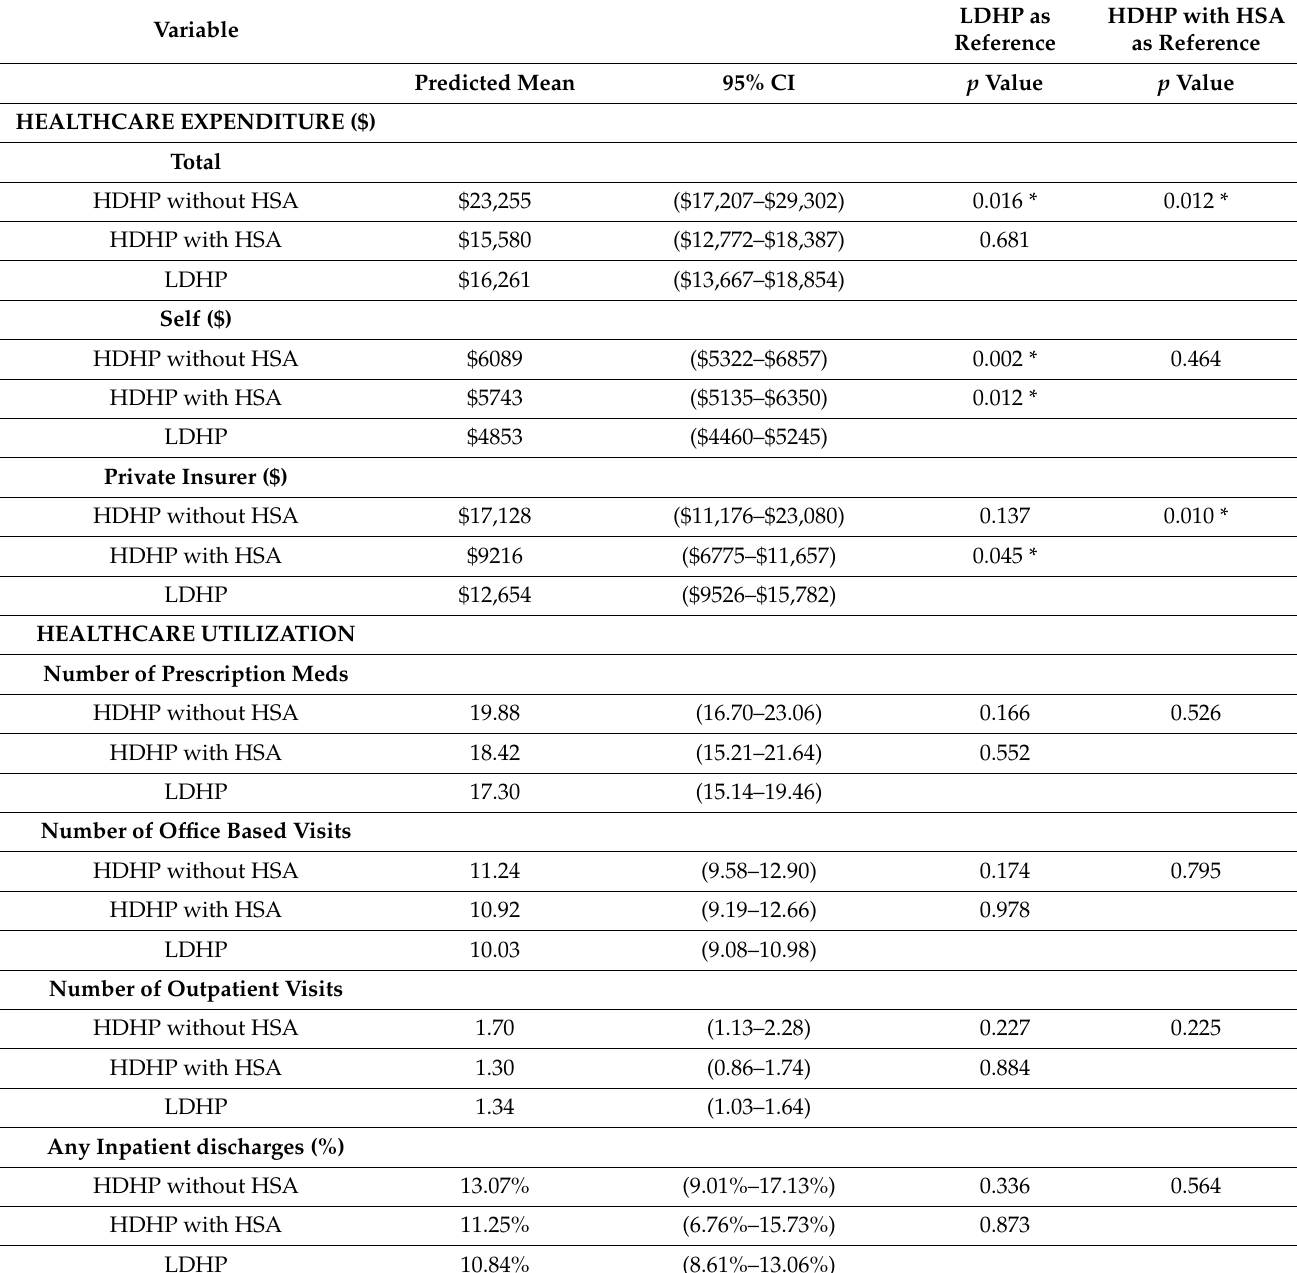
Table 2. Results from the Generalized Linear Models using Double Robust (DR)